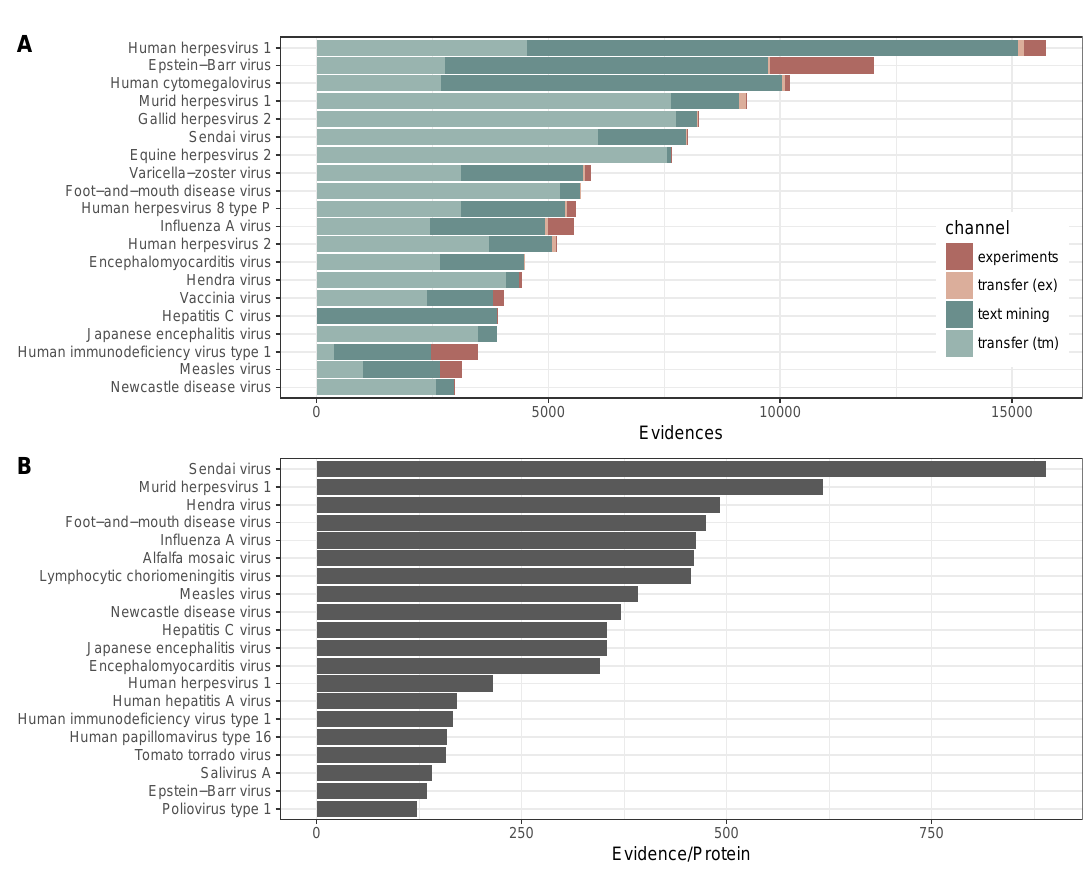
Figure 2. Intra- and intervirus interactions in viruses.STRING by species. ( A ) distribution of experimental (red) and text mining (green) interactions present in the database, further divided into direct (dark red and dark green) and transferred (light green and pink) evidence. Data is shown for the 20 viruses with the most evidence. Evidence may be between two proteins of one virus species, or between a virus protein and a host protein. Evidence is counted as interaction pairs per channel, such that an interaction that is supported by three channels will be counted as 3 evidences. The sources of evidence that is transferred may originate from experimental (abbreviated ex in the figure) or from text mining (tm) data; ( B ) amount of evidence normalized by the number of proteins coded for by that